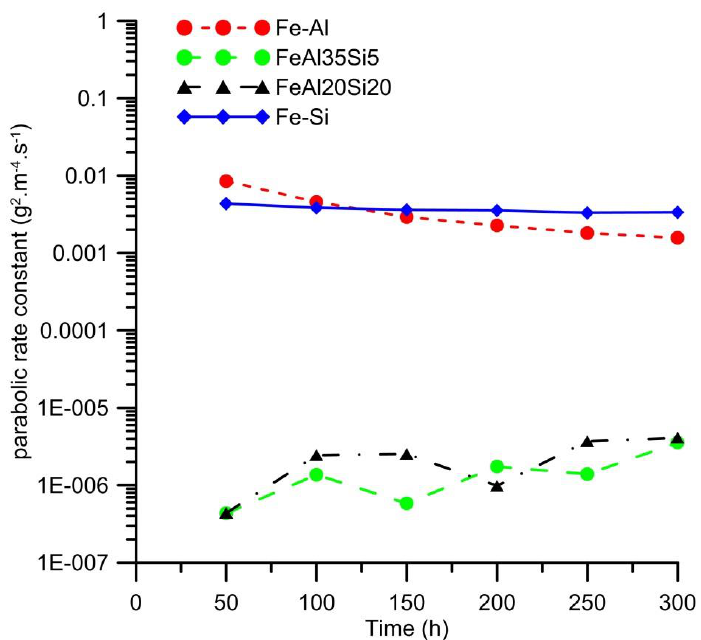
Figure 3. Calculated parabolic rate constants of cyclic oxidation of the tested alloys vs. oxidation duration.